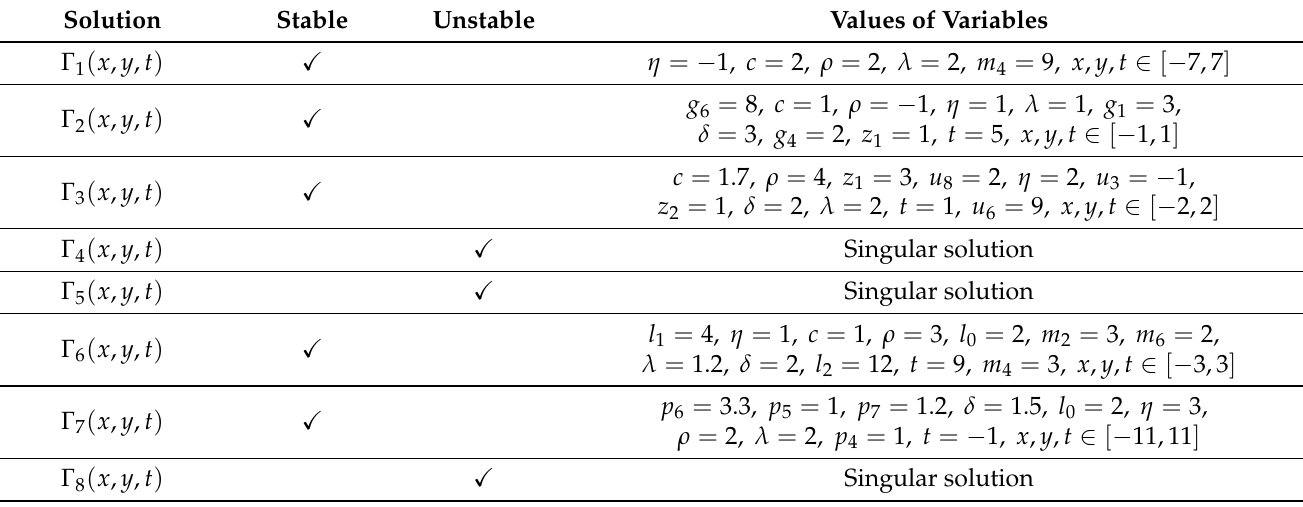
Table 1. Stability properties of the solutions Γ i ( x , y , t ) , where ( i =